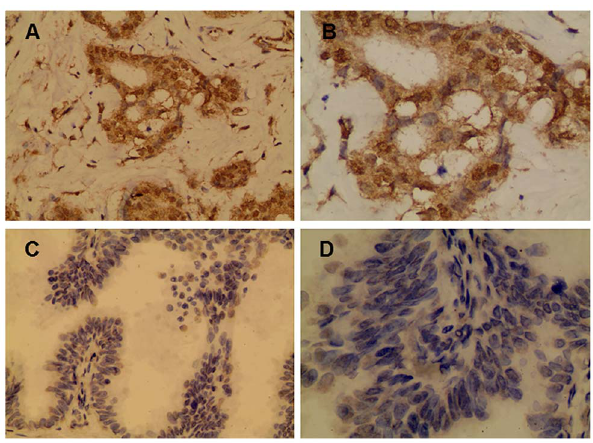
Figure 3. Immunohistochemistry staining of HLA-G expression in breast cancer lesions. Positive HLA-G staining (original magnifi- cation, 6 200 for A and 6 400 for B). Negative HLA-G staining (original magnification, 6 200 for C and 6 400 for D).